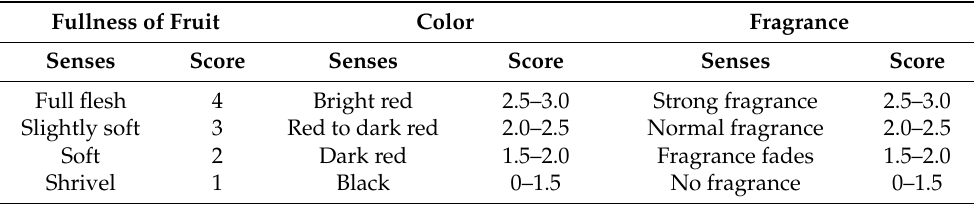
Table 1. Sensory Quality Evaluation